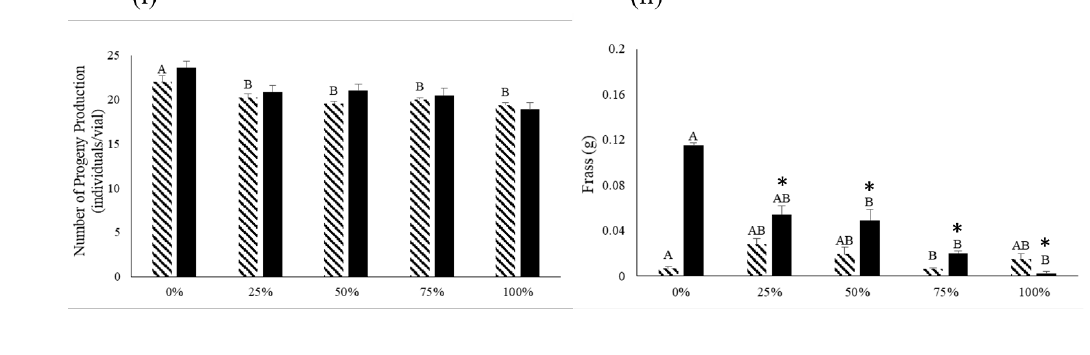
For progeny production, the O’Brien test for fortification was F = 3.636, p = 0.006. For frass, Log10-transformed Levene test for treatment was F = 0.99 p = 0.4184 and the O’Brien test for fortification was F = 3.65, p = 0.0599. For NDK, Log10-transformed Levene test for treatment was F = 2.07, p = 0.0972 and, for fortification, was F = 0.20, p = 0.6516. For WDK, Log10-transformed Levene test for treatment was F = 1.93, p = 0.1170 and, for fortification, was F = 0.92, p = 0.3409.